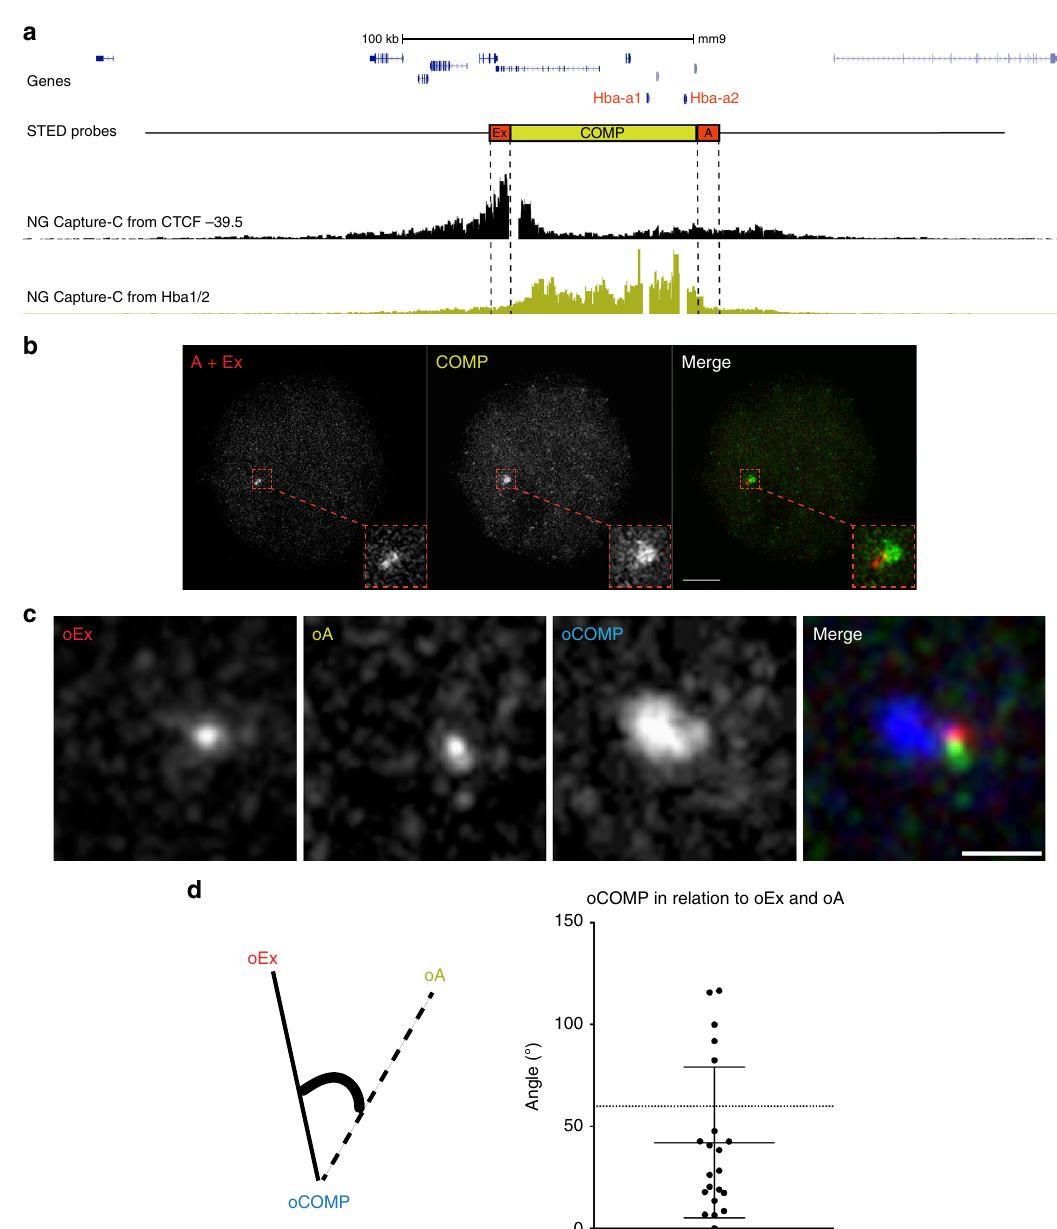
Fig. 5 Super-resolution imaging of the α -globin domain. a Gene map with FISH probe Ex, COMP and A locations marked against NG Capture-C tracks depicting interactions at MFL 30 h from the viewpoints CTCF BS -39.5 (black) and Hba1/2 promoters (lime green). b 2D STED maximum intensity projection images of FISH probes A and Ex (both red) which fl ank the α -globin domain, the COMP BAC (green) de fi ning the extent of the domain and a merged image showing a cloud of domain signal distinct from the paired probes A and Ex. Scale bar 2 μ m. c Three-colour 3D STED maximum intensity projection images of oligonucleotide probe pools (oEx, oCOMP and oA) designed to match the probe set shown in a . The oCOMP probe (blue) detects a cloud of signal that is distinct from the adjacent probes oEx (red) and oA (green). Scale bar 0.5 μ m. d A drawing describes the angle measured in Euclidean 3D space between vectors joining the oCOMP signal with oEx and oA. The angles measured are charted on the right, with a median of 42°, well below an expected 60° for a random distribution. n =